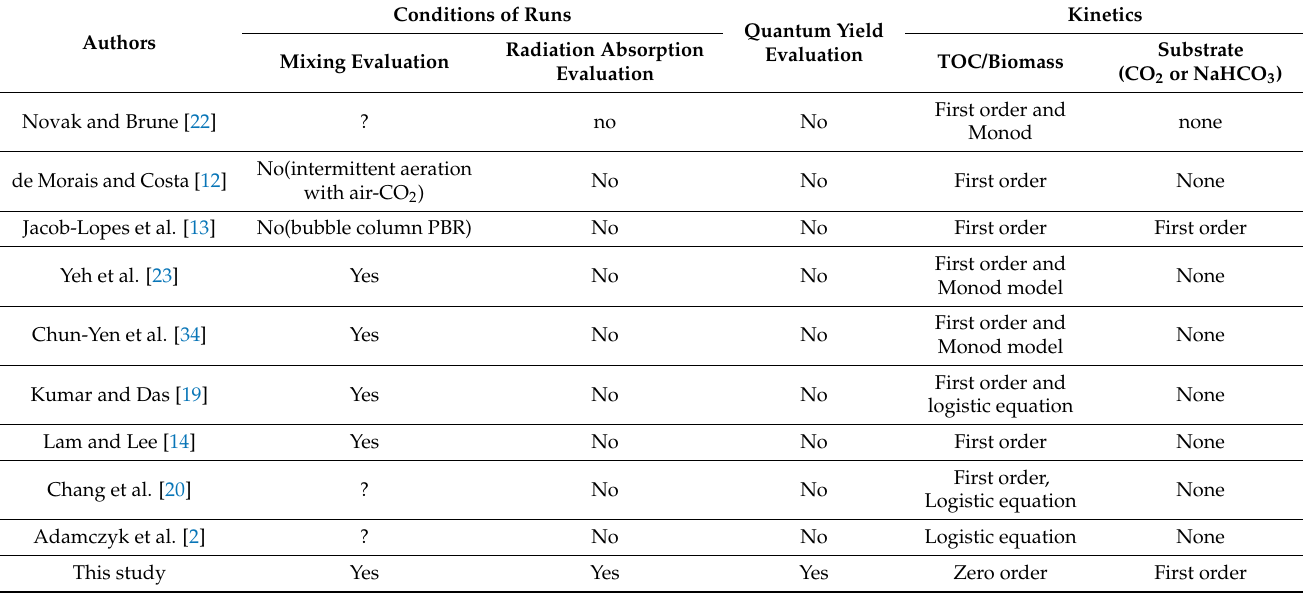
Table A1. Microalgae kinetic models reported in the technical